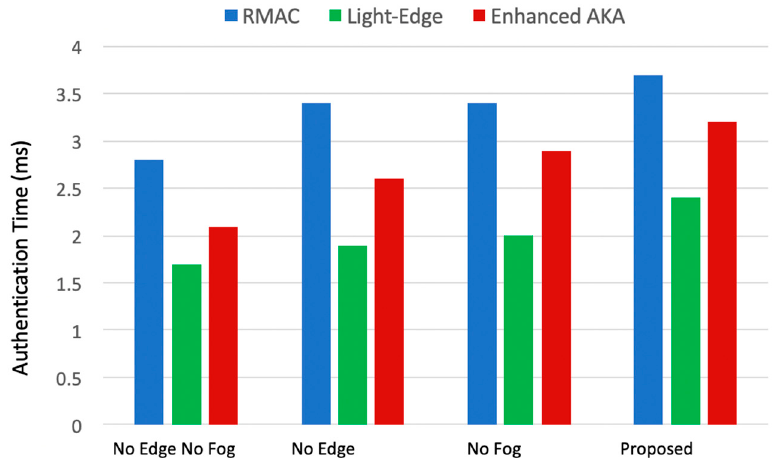
Figure 5. The authentication time of RMAC, Light-Edge, and enhanced AKA for the four system configurations. configurations.